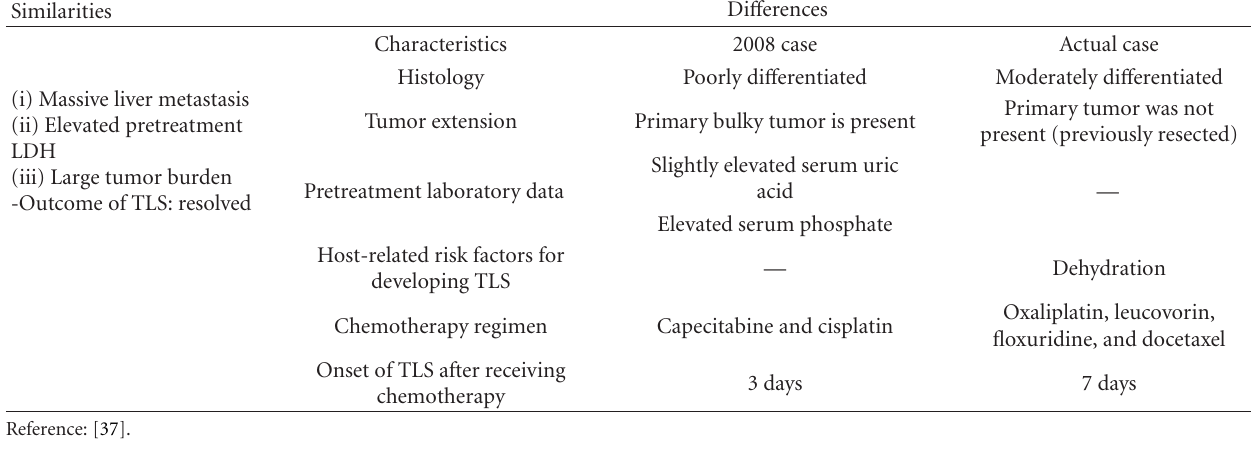
Table 5: Similarities and di ff erences between chemotherapy-induced TLS in advanced gastric adenocarcinoma reported in 2008 and our case.